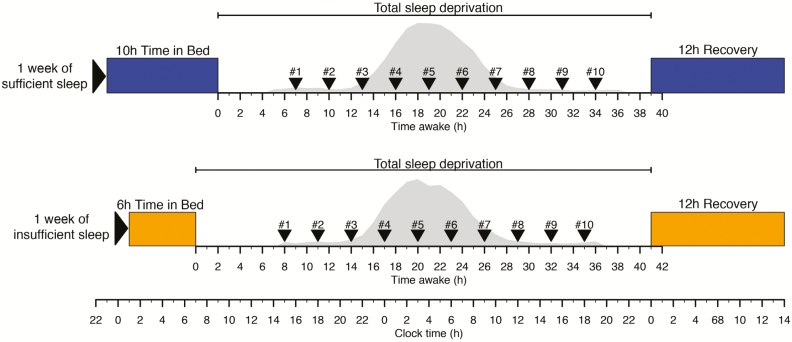
Protocol. In a crossover design participants entered a constant routine following either 1 week of sufficient (mean ± SEM of PSG assessed TST of 8.56 ± 0.06 hr) sleep or 1 week of insufficient (mean ± SEM of PSG assessed TST of 5.75 ± 0.06 hr) sleep. During the constant routine of 39–41 hr of wakefulness blood samples were collected 3 hourly for transcriptome samples (samples labeled #1 to #10) and hourly for melatonin assessments. At the end of each constant routine participants were given a 12 hr recovery period. Melatonin curves (gray area) represent the average melatonin curve (across all participants) during the constant routine for sufficient and insufficient sleep, respectively.